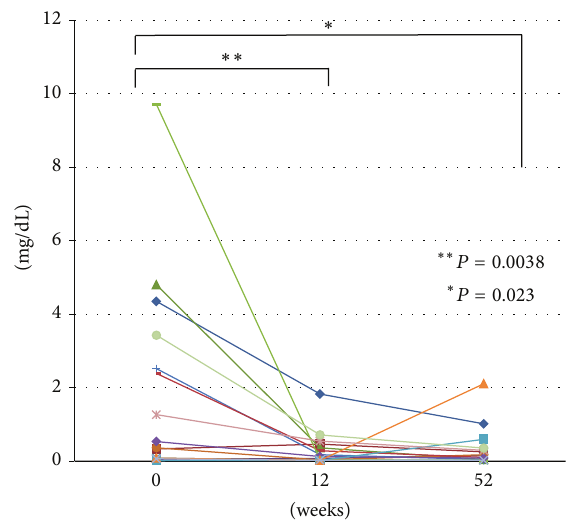
Figure 2: Serum levels of C-reactive protein (CRP) before and at 12 and 52 weeks after the start of adalimumab (ADA)